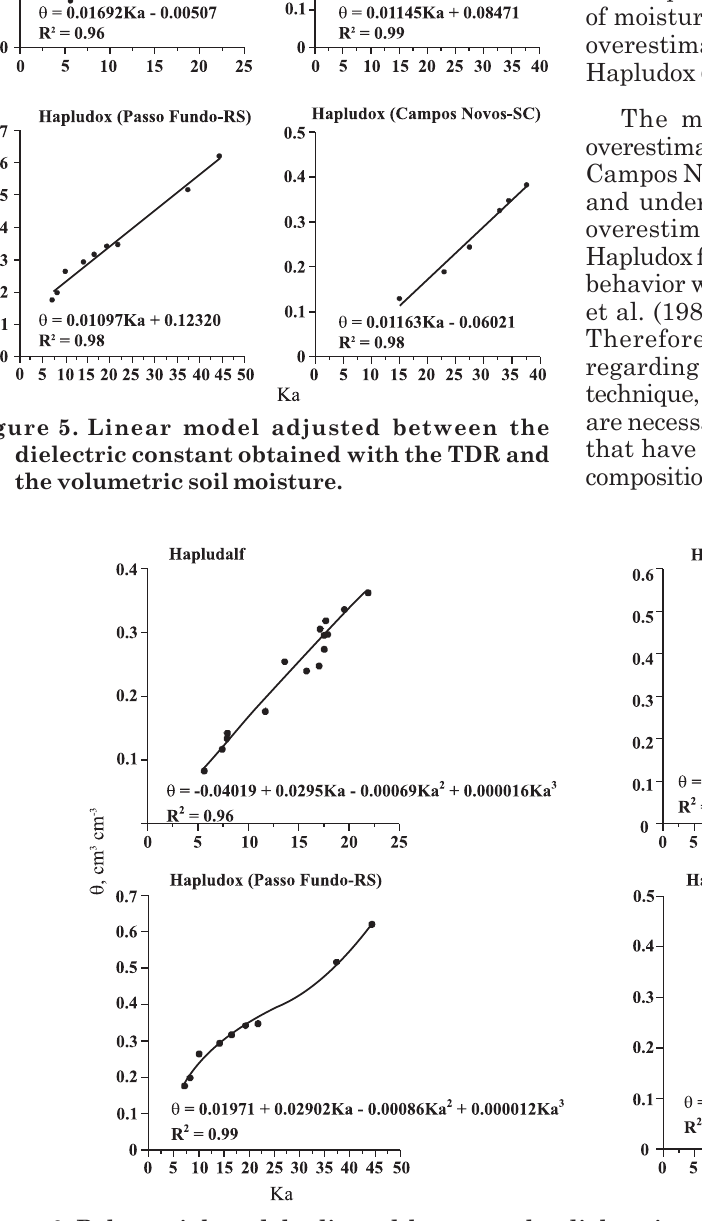
Figure 6. Polynomial model adjusted between the dielectric constant obtained with the TDR and the volumetric soil